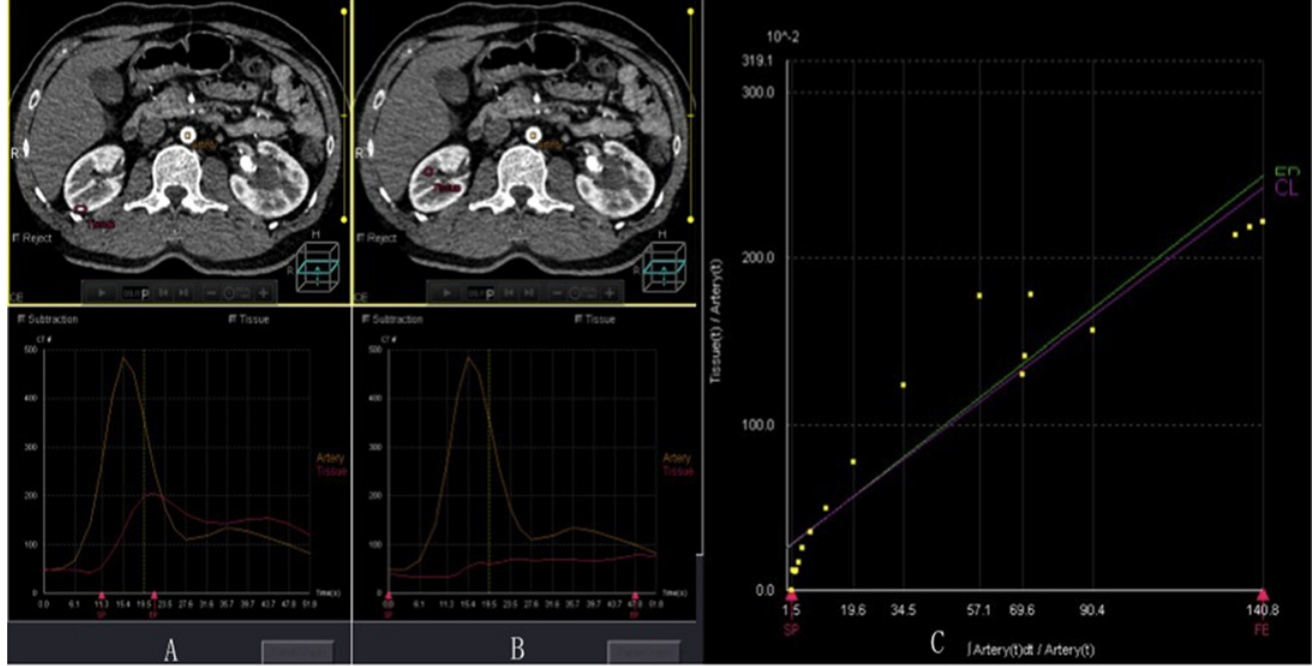
Fig 1. Time – density curves (TDCs) of renal cortex (a) and medulla (b) from the single input maximum slope and Patlak graph from the Patlak plot (c). TDC indicates the enhancement characteristics of the aorta and renal cortex or medulla during the first pass. BF can be determined from the maximum gradient of renal cortical or medullary TDC divided by the peak enhancement of the aorta. The Patlak plot is a graphical analysis method, which quantifies the passage of contrast from the intravascular space into the extravascular space. BV and CL can be obtained from the Patlak equation. TDC curve: SP: start phase; EP: end phase. Patlak graph: SP: start phase; FE: flow end; EP line: early perfusion regression line (green line); CL line: clearance regression line (purple line). BF, blood flow; BV, blood volume; CL, clearance.